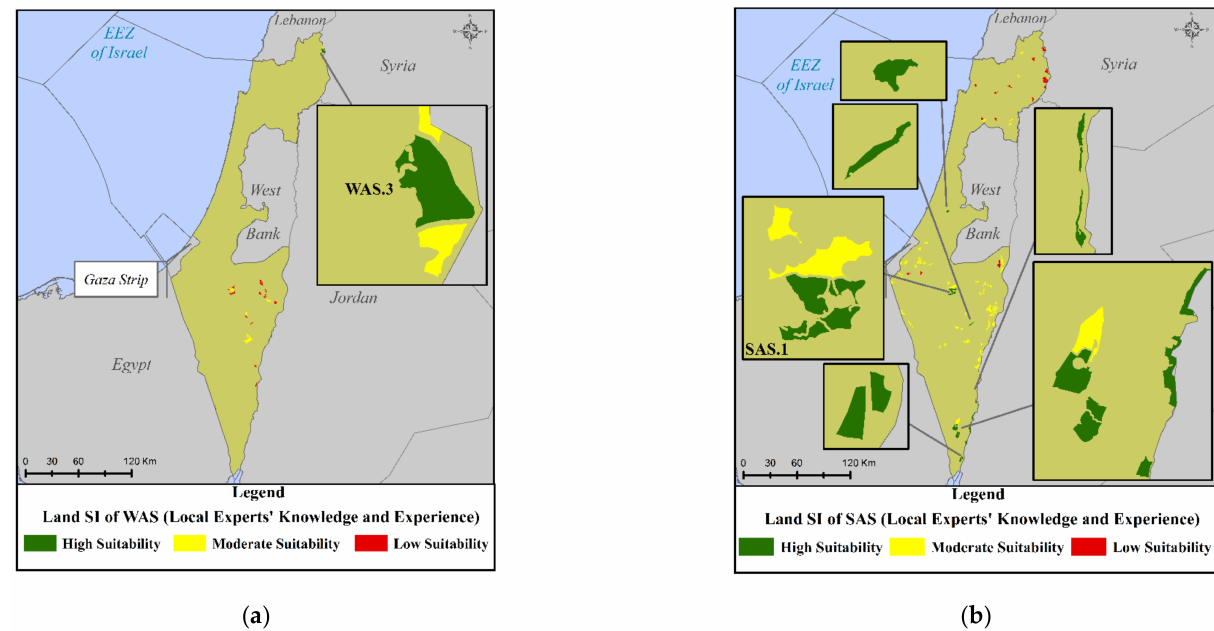
Figure 11. Suitability Index (SI) spatial allocation based on Local Experts (LEs) for: ( a ) Wind Appropriate Sites (WAS) and ( b ) Solar Appropriate Sites (SAS).